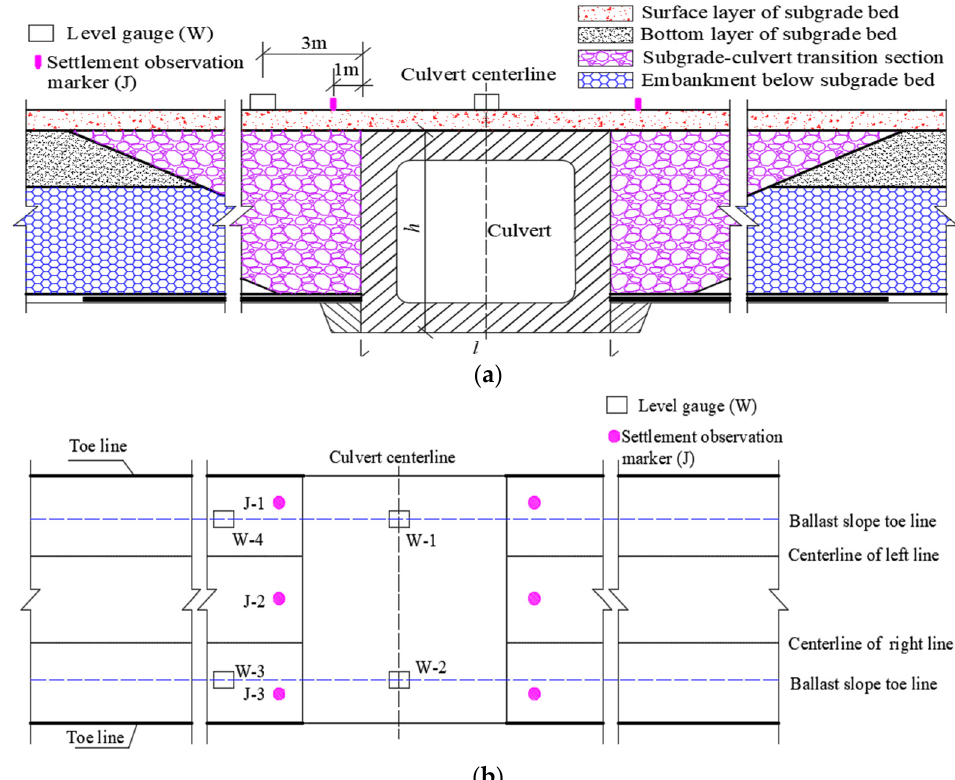
Figure 2. Schematic diagram of component layout in the existing railway. ( a ) profile diagram; ( b ) flat